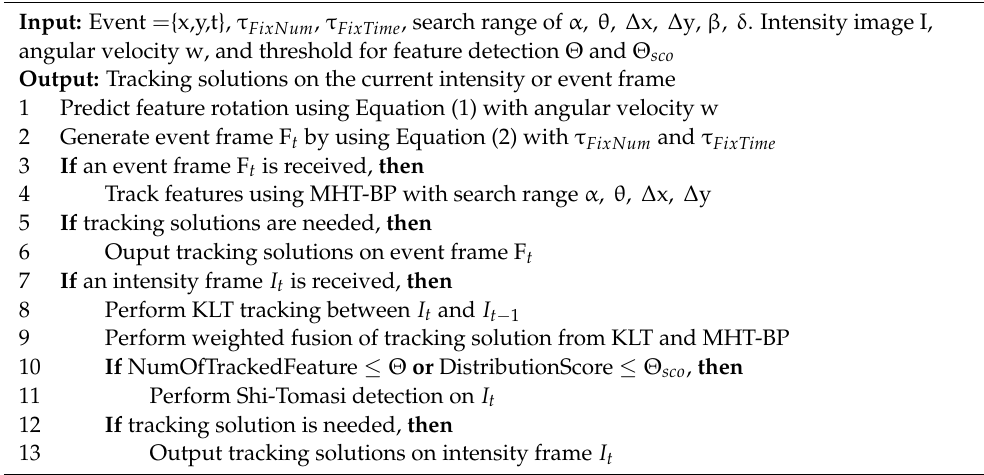
Algorithm 1: Feature-tracking method based on integration of event, intensity and inertial information (WF-MHT-BP)